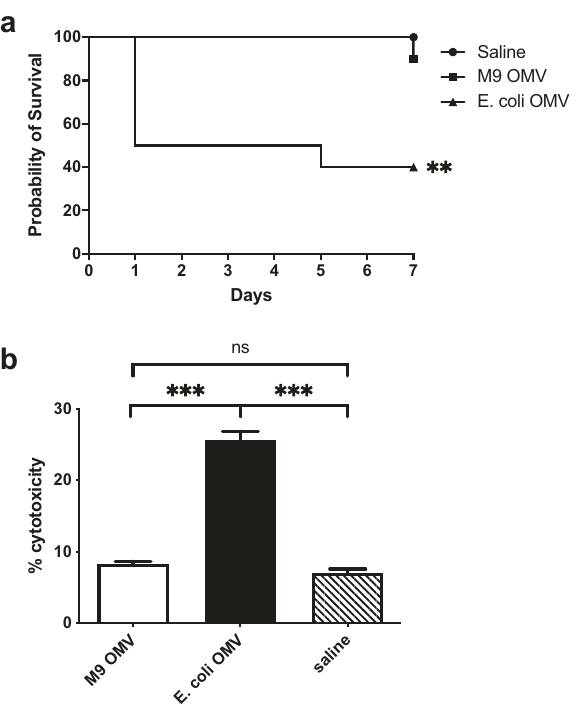
Fig. 2 M9 OMVs are non-toxic to living cells. a G. mellonella ( n = 10 per group) were inoculated with 10 μ g Bp82 M9 OMVs, E. coli OMVs, or saline. E. coli OMVs caused signi fi cant mortality whereas M9 OMV and saline did not (** p < 0.01 by log rank Mantel Cox test). b RAW 264.7 murine macrophages were treated with saline, 10 μ g M9 OMVs or E. coli OMVs and LDH release was measured 24 h later (*** p < 0.001, n.s. = not signi fi cant by unpaired Student ’ s t test). Results shown are representative of three independent experiments.